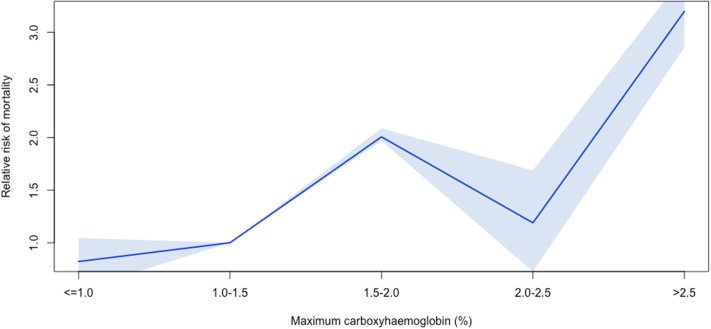
Risk adjusted mortality according to categories of maximum COHb, relative to a maximum COHb value between 1.0–1.5%.The shaded blue area represents the 95% confidence interval. Risk of mortality is adjusted for PIM-3, age, and length of ventilation. The U-shaped relationship described by Melley et al in adults is not seen—COHb values < = 1.0 have a non-significantly lower risk adjusted mortality relative to children with a maximum COHb between 1.0–1.5%.